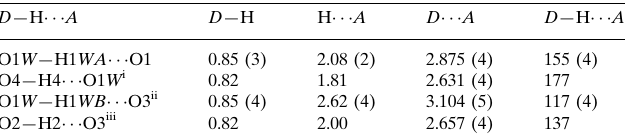
Hydrogen-bond geometry (A˚ , (cid:3)